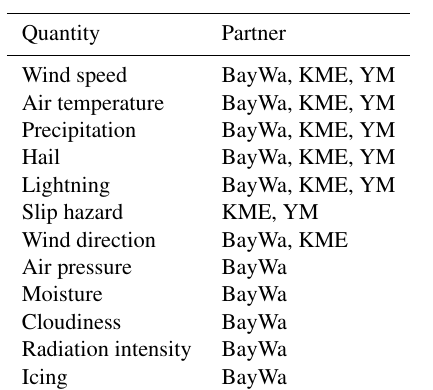
Table 1. Requested weather information of the use cases: ressource assessment for wind farms, e-mobility, and event